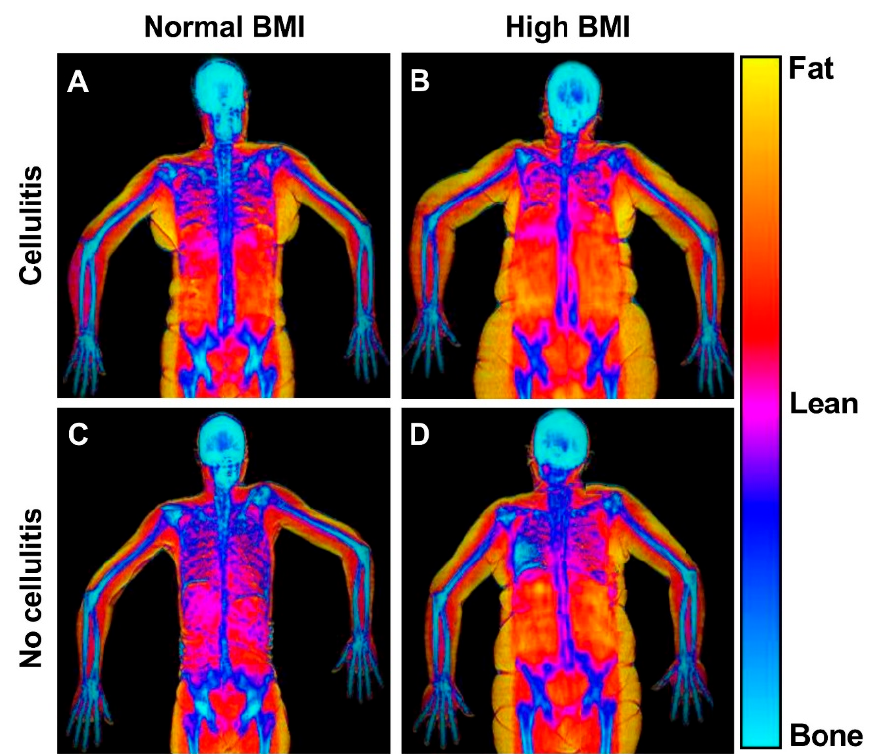
Figure 5. DEXA scans of patients with and without high BMI and previous cellulitis. This figure shows representative frontal plane DEXA scans of patients with normal and high BMI and with and